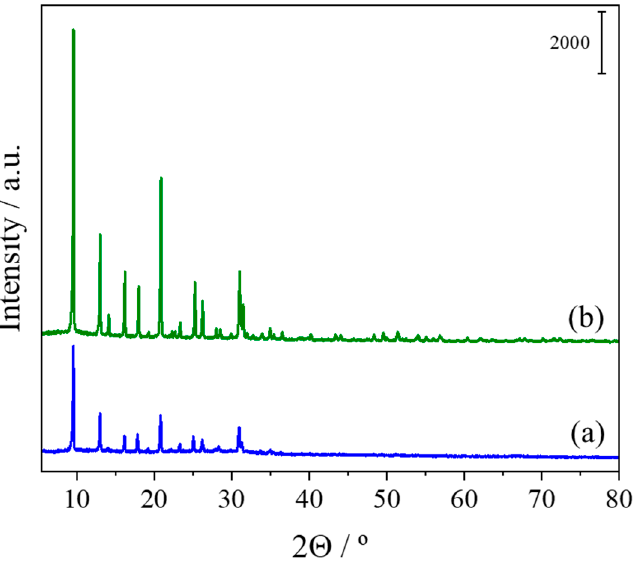
Table 1. Surface area, pore volume and cell unit parameters of the Cu zeolites.